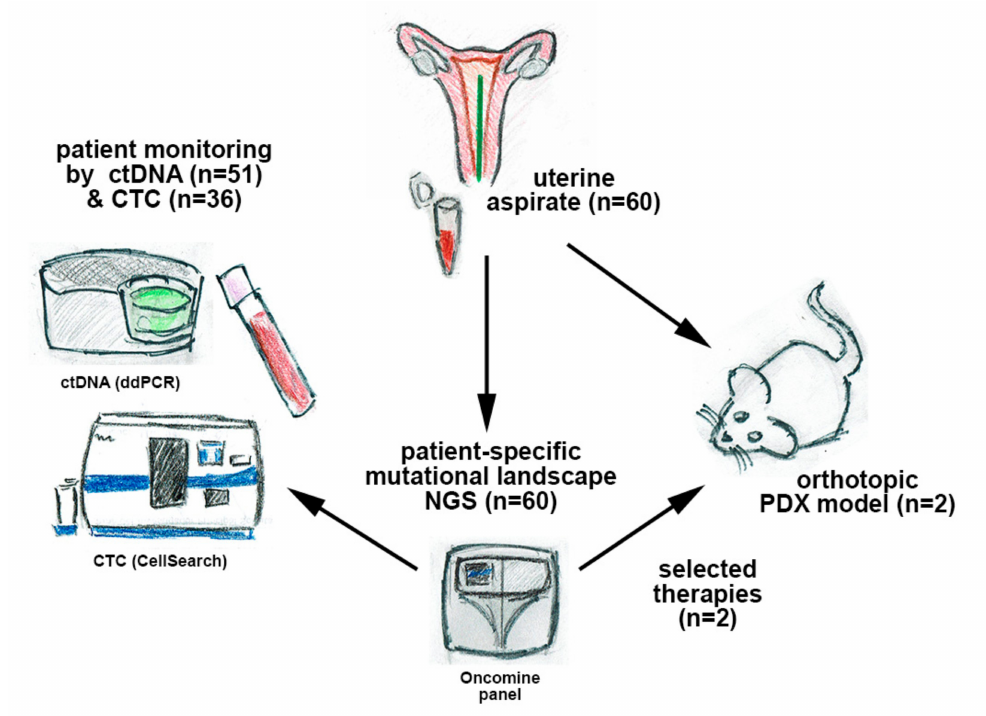
Figure 1. Scheme representing the workflow of the study with the samples and analyses